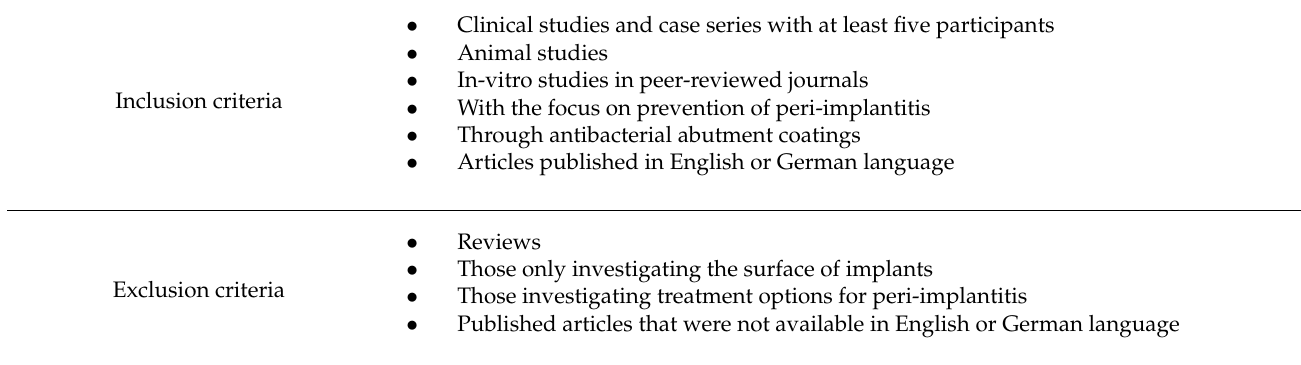
Table 1. Inclusion and exclusion